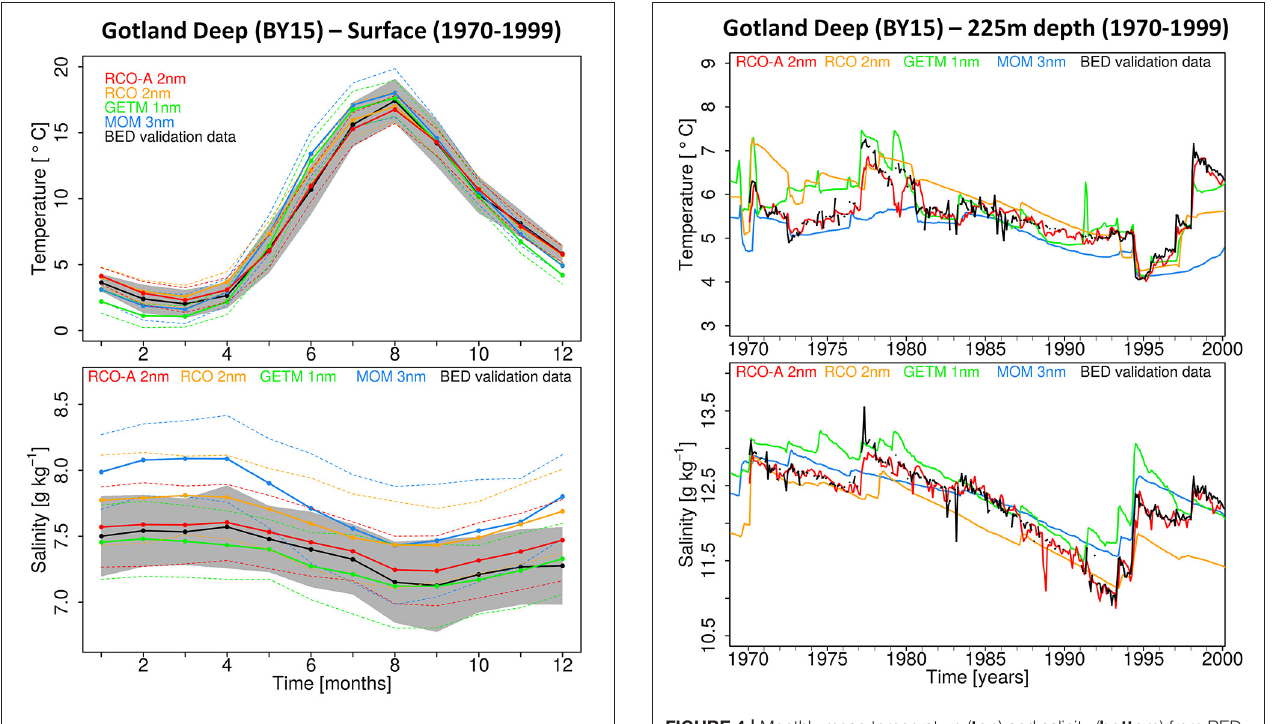
FIGURE 3 | Thirty-year mean annual cycles of monthly sea surface temperature ( top ) and salinity ( bottom ) from BED observation data (black) and the ocean models RCO-A (red), RCO (orange), GETM (green), and MOM (blue) at the monitoring station Gotland Deep (BY15) for the time period from 1970 to 1999. Mean values are illustrated by solid lines. Standard deviations are indicated by the gray-shaded area for the BED data and by the colored dashed lines for the models.